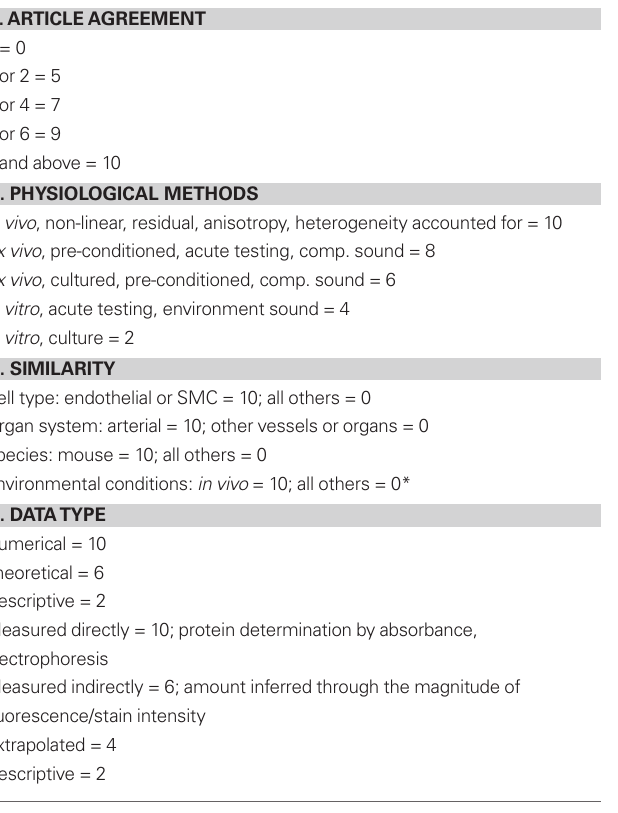
Table 2 | rule-scoring rubric. Table 3 | confidence